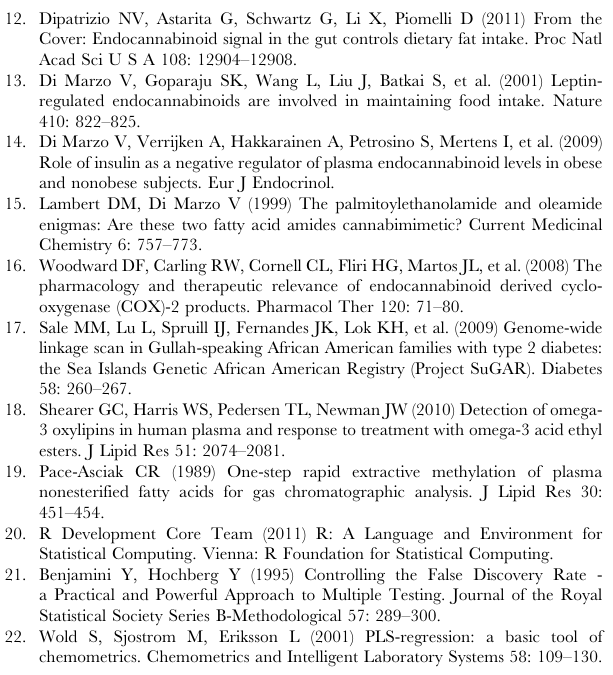
Table S1 Diabetes x UCP3 G304A polymorphism 2-way ANOVA p-values for Type 2 diabetes associated meta- bolic changes. Type 2 Diabetes associated changes were not significantly different between evaluated UCP3 genotypes and no interactions were identified. Table S2 NAE, MAG and LAA mass transitions. This table lists the positive mode electrospray ionization mass transitions used to detect and quantify the listed analytical targets. Table S3 Analytical surrogate recoveries. The recovery and precision of analytical surrogates associated with non- esterified fatty acids (n= 1), endocannabinoids (n= 8) and oxylipins (n =6) are reported. Table S4 Average modeling statistics for type 2 diabetes predictive models. Orthogonal projection to latent structures discriminate analysis (OPLS-DA) models were constructed using either metabolites or clinical parameters. Both models accurately discriminated diabetic status, with the metabolite-based model slightly out-performing the clinical model in terms of model fit and the area under the receiver operator characteristic curve for model based prediction. Table S5 Plasma non-esterified fatty acids ( m M) in obese African-American women. Geometric mean and ranges are listed for all measured metabolites in this class.